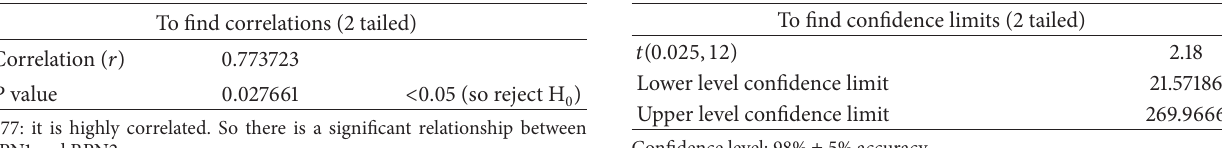
Table 6: Paired correlations report.